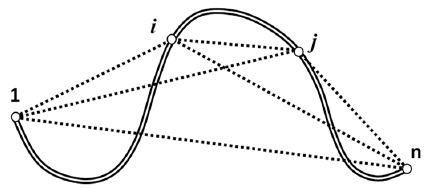
Figure 1. Ideal non-planar road network.